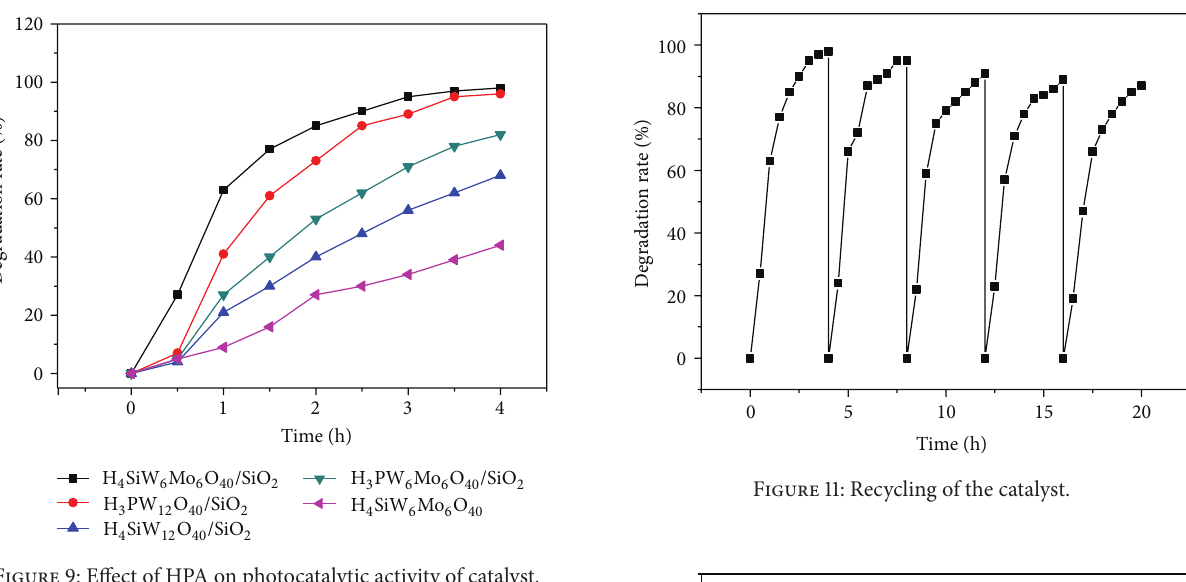
Figure 9: Effect of HPA on photocatalytic activity of catalyst.